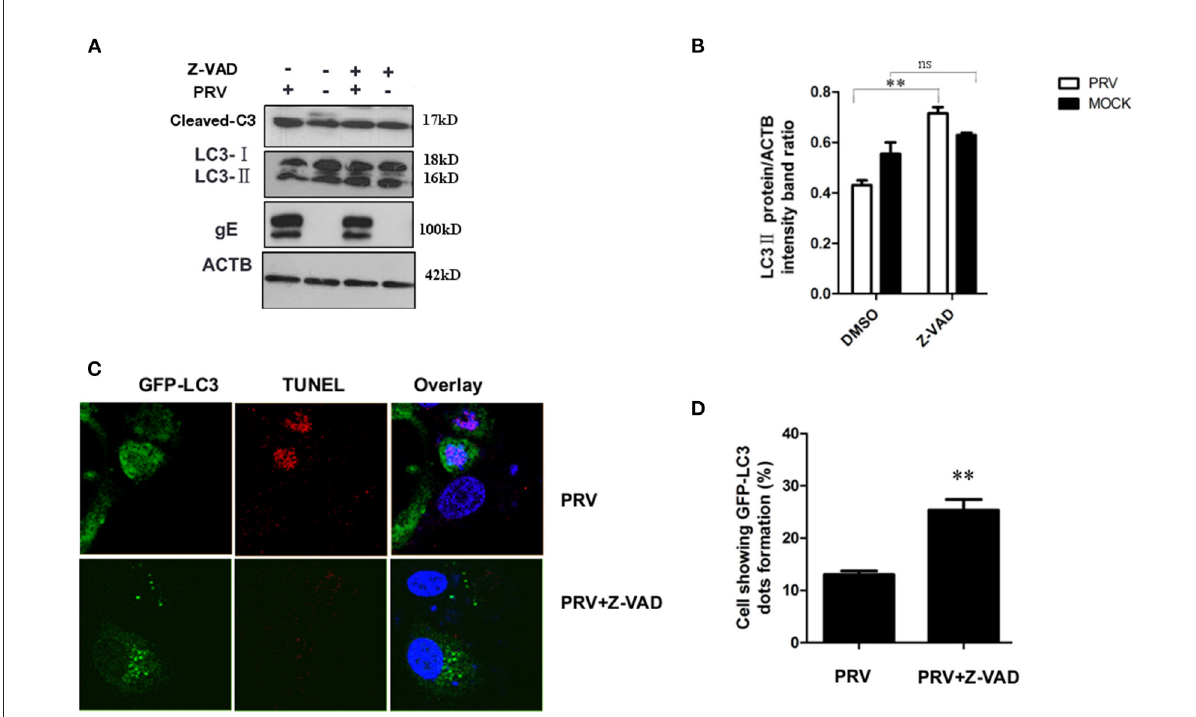
FIGURE4 Inhibition of apoptosis increases the autophagy level in PRV-infected cells. (A) PK-15 cells were pre-treated with Z-VAD-FMK for 4h, followed by PRV infection for an additional 12 hpi. The cells were lysed and analyzed by Western blot, and the statistical analysis of LC3-II to ACTB and P62 to ACTB was performed, shown in (B) . (C) PK-15 cells were transfected with the GFP-LC3 for 24h and pre-treated with Z-VAD-FMK for 4h followed by PRV infection. Confocal microscopy was used to locate the GFP-LC3 puncta and TUNEL stain. (D) the percentage of cells showing GFP-LC3 dots formation and at least 50 cells were included in each group. All the results are representatives of the three independent experiments. The data represent the mean ± SD of three independent experiments and are analyzed by one-way ANOVA or two-way ANOVA, ** P <